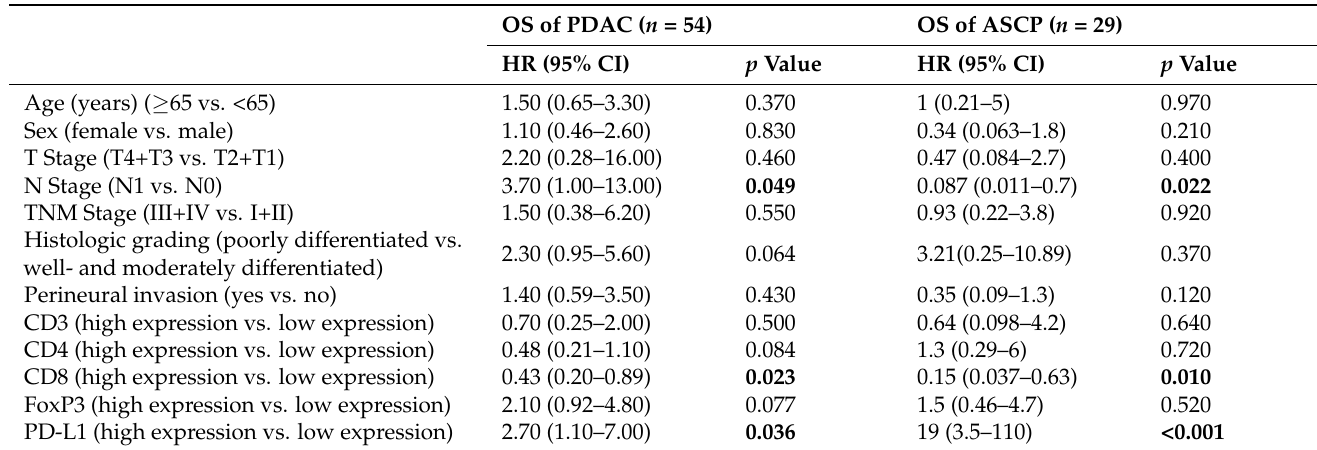
Table 3. Multivariate analysis with Cox proportional hazard